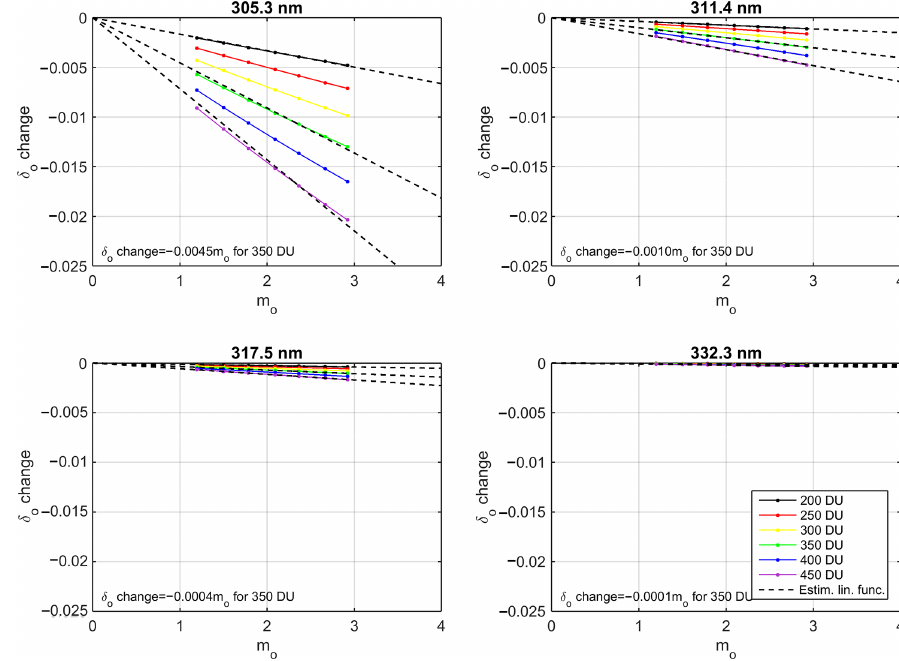
Figure 2. Calculated change in effective ozone optical depth with air mass due to the UVPFR filter